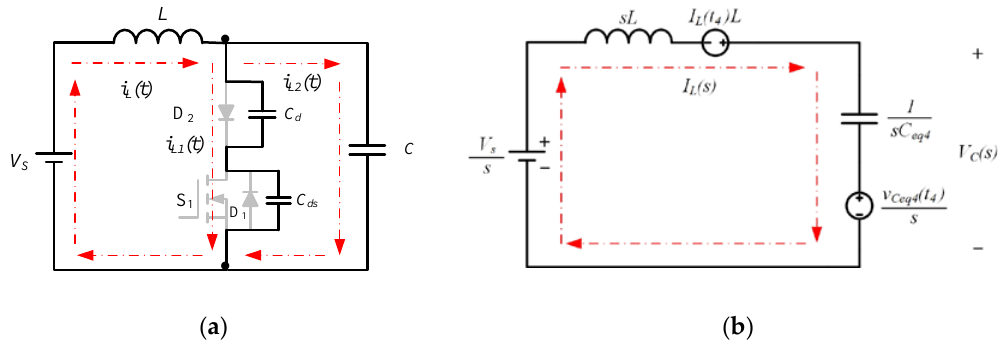
Figure 7. Mode 4 principle: ( a ) the equivalent circuit; ( b ) the Laplace transform circuit.